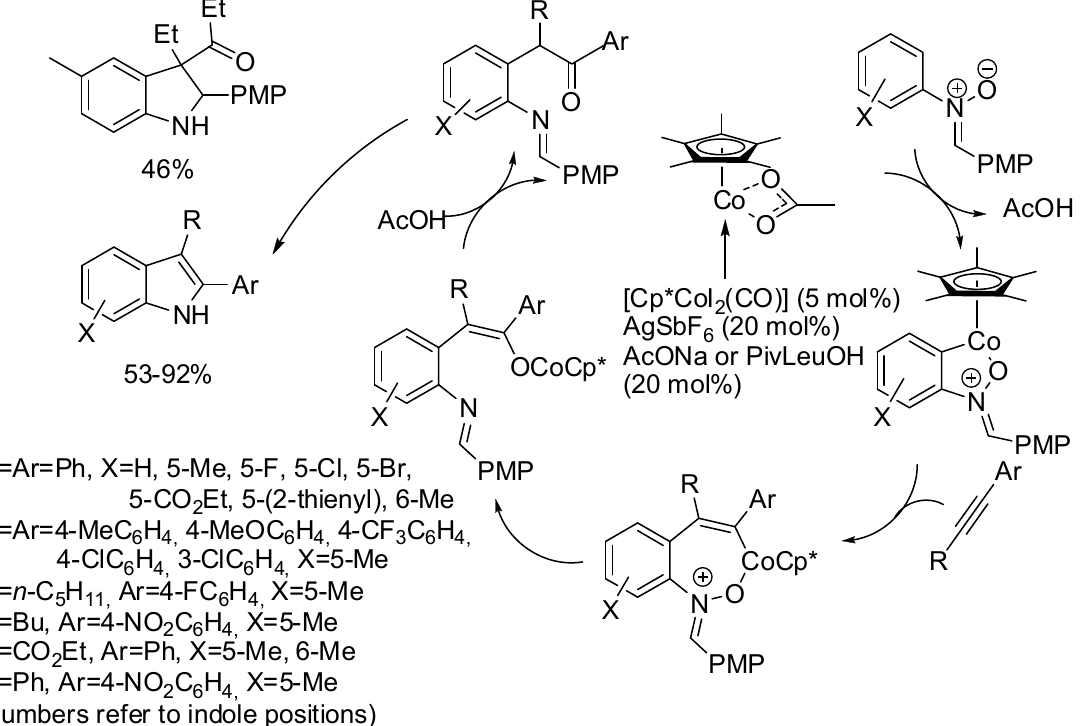
Scheme 2. Cobalt(III)-catalyzed indolization with